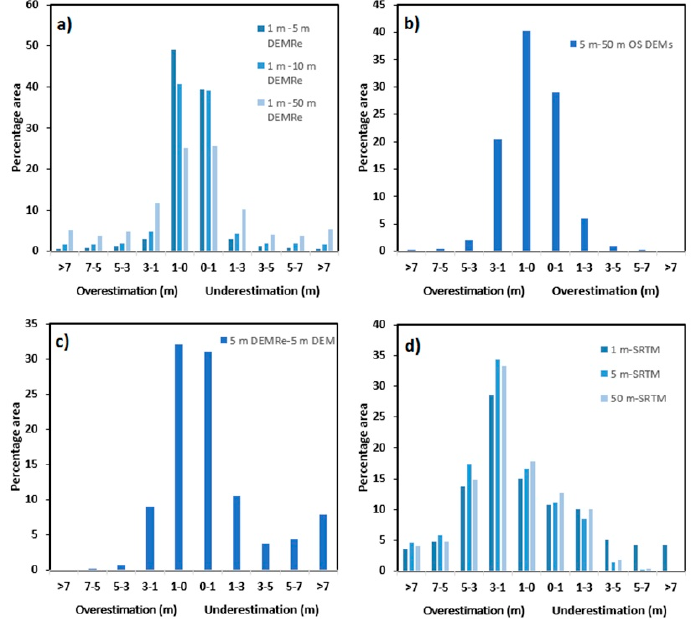
Figure 9. Percentage of areas overestimated and underestimated in DEMs when: ( a ) resampled 5 m DEM Re , 10 m DEM Re , and 50 m DEM Re , are compared with the original 1 m LiDAR DEM, ( b ) 50 m OS DEM is compared to the 5 m OS DEM, ( c ) 5 m OS DEM (DSM) is compared to the resampled 5 m DEM Re , and ( d ) SRTM elevations DEM is compared with the other elevation datasets.